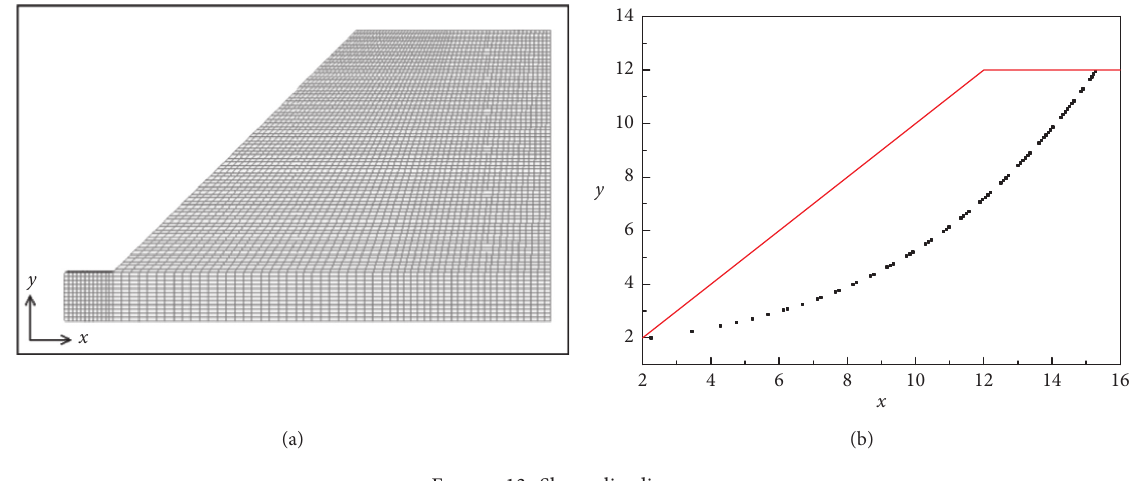
Figure 13: Slope slip